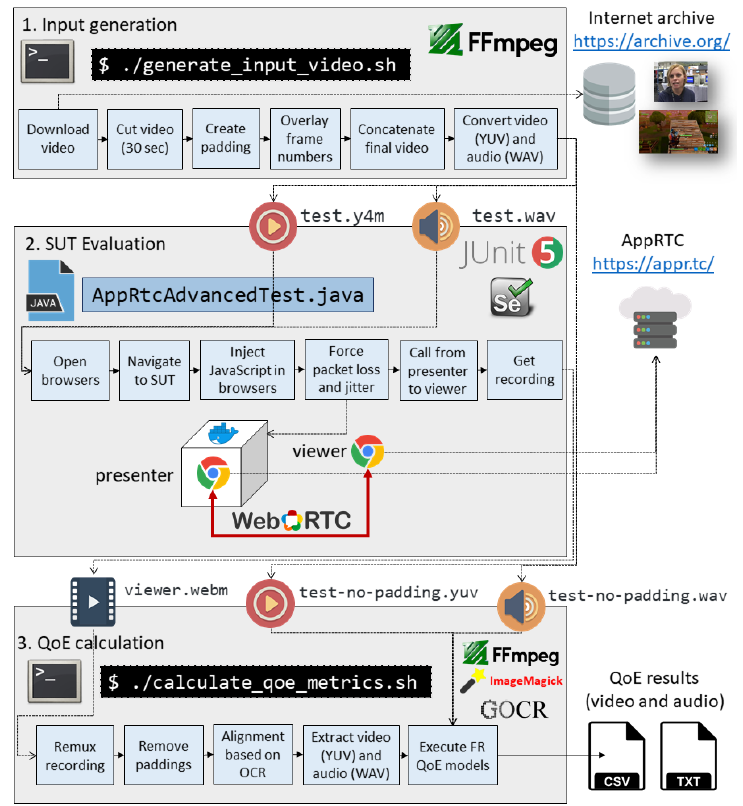
Figure 2. Objective assessment